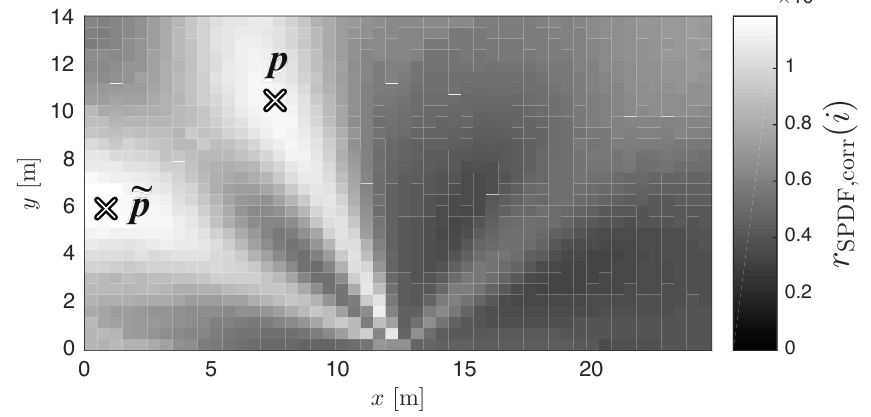
Figure 10. SPDF example for a NLOS measurement, resulting in a large localization error (cid:101) loc and a small surface